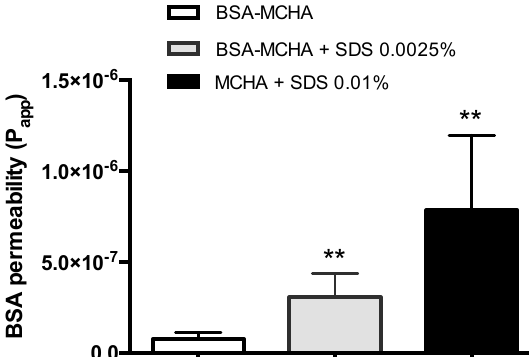
Figure 5. Fluorescein isothiocyanate-labeled bovine serum albumin (FITC-BSA) permeability across Caco-2 monolayers following application of FITC-BSA-containing methylcellulose (MC)-hyaluronic acid (HA) (MCHA) hydrogel, with or without sodium dodecyl sulfate at 0.0025% and 0.01% w / v . FITC-BSA permeability was quantified by fluorescence. Data shown as the mean ± SD ( n = 4). ** indicates p < 0.01.